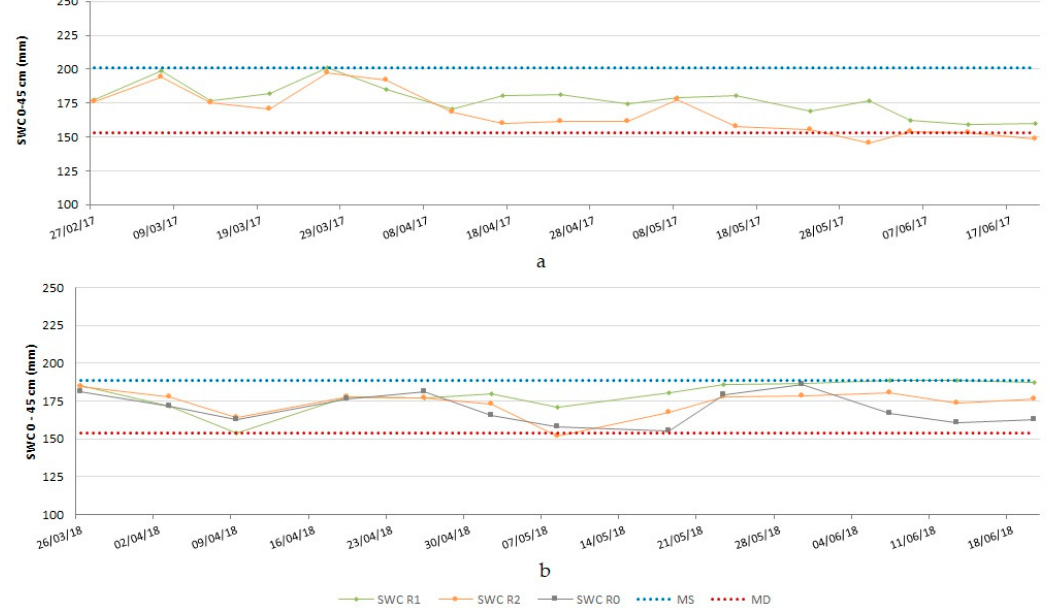
Figure 2. Soil water content (SWC; mm of water in the 0–45 cm soil profile) in the different water regime treatments. a -2016 / 2017 crop cycle; b -2017 / 2018 crop cycle. R1, irrigation with 100% of ETc; R2, irrigation with 100% of ETc at critical stages of beginning of stem extension, booting, heading, and grain filling. MS, maximum storage during the growth cycle (mm of water in the 0–45 cm soil profile); MD, maximum allowed depletion during the growth cycle (mm of water in the 0–45 cm soil profile).